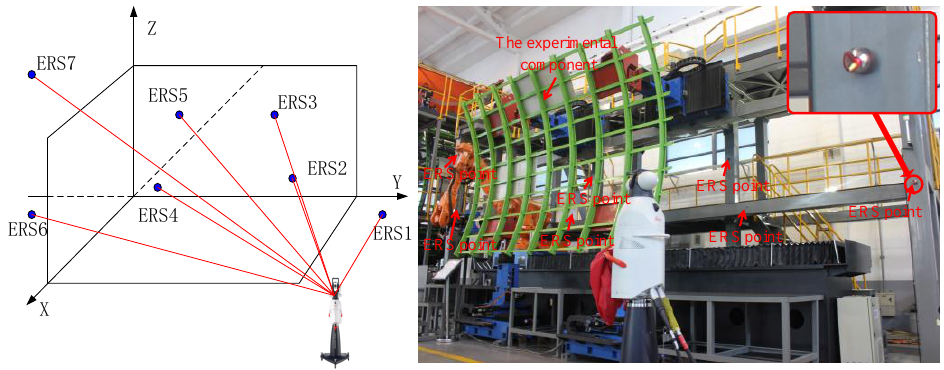
Figure 2. The overall layout of the experiment.